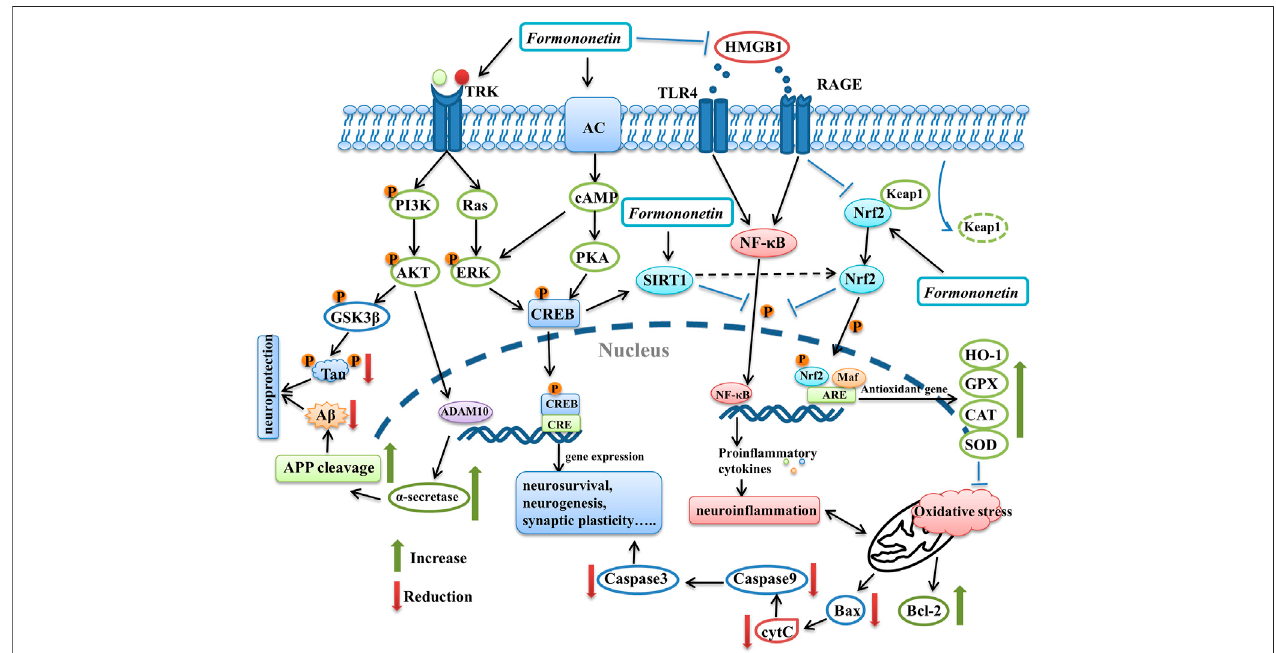
FIGURE 3 | The graphical summary of signaling pathways underlying the neuroprotective effects of formononetin. It bene fi ts multiple aspects of nervous system, suchaspromotingneurosurvival,neurogenesisandsynapticfunction via modulationPI3K/AKTpathway, ERKpathway,PKA/CREBpathway.Formononetinattenuates neuroin fl ammation through inhibiting HMGB1/TLR4/NF- κ B pathway and RAGE pathway. It can also inhibit oxidative stress and neuronal apoptosis through activating Nrf2pathway.Inaddition,SIRT1isalsoinvolvedintheneuroprotectiveeffectsofformononetin.PI3K,phosphatidylinositol3-kinase;AKT,proteinkinaseB;GSK3 β , glycogen synthase kinase-3 β ; ADAM10, A-Disintegrin-And -Metalloproteinase 10; APP, amyloid precursor protein; AC, adenylate cyclase; cAMP, cyclic adenosine monophosphate; PKA, protein kinase A; CREB, cAMP response element-binding protein; TRK, receptor tyrosine kinase; HMGB1, high mobility group box-1 protein; TLR4,toll-likereceptor4;RAGE,receptorsforadvanced glycation-endproducts;NF- κ B,nuclearfactorkappa-B;Nrf2,nuclearfactorerythroid2-relatedfactor2;HO-1, heme oxygenase-1; GPX, glutathione peroxidase; CAT, catalase; SOD, superoxide